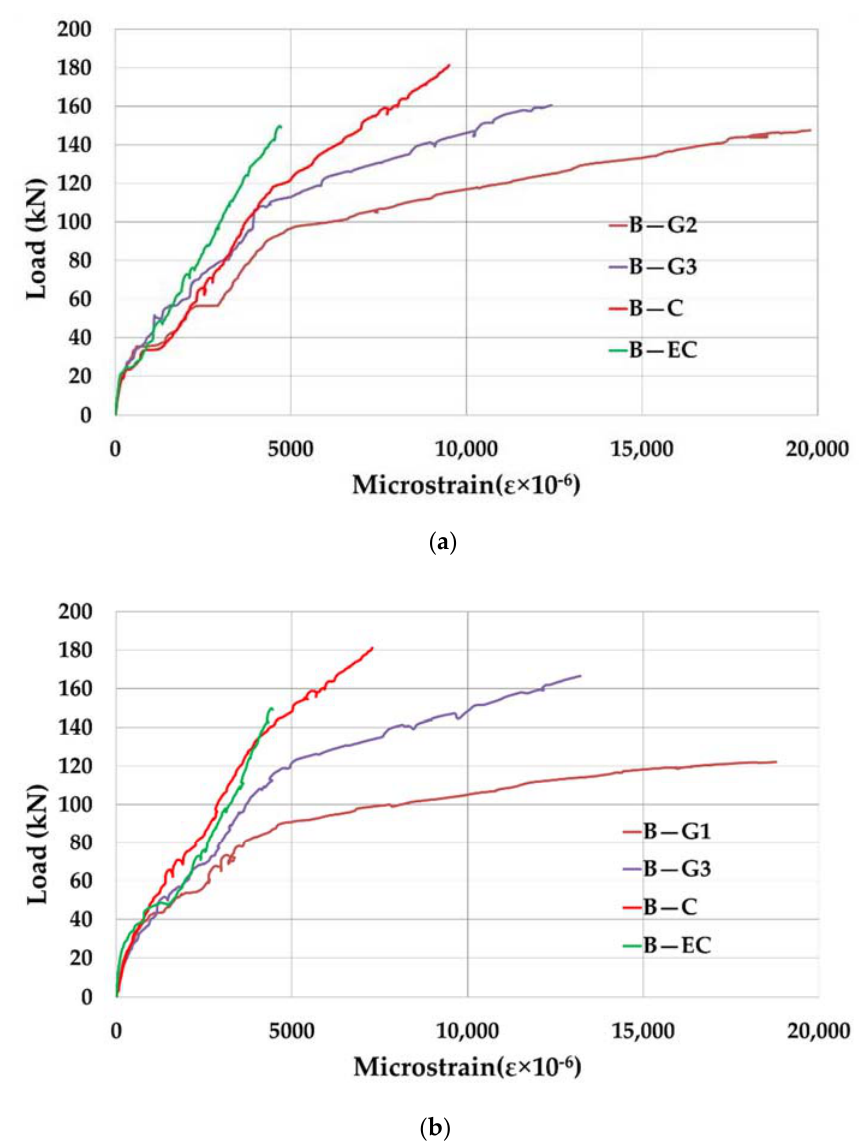
Figure 14. Load vs. microstrain curves in FRP reinforcement for the section: ( a ) At the middle of span—Section I; ( b ) Above the middle support—Section III.